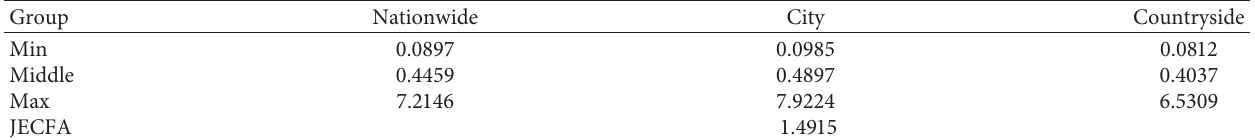
Table 4: The exposure of sulfonamides in animal products ( μ g/d ▪ person).